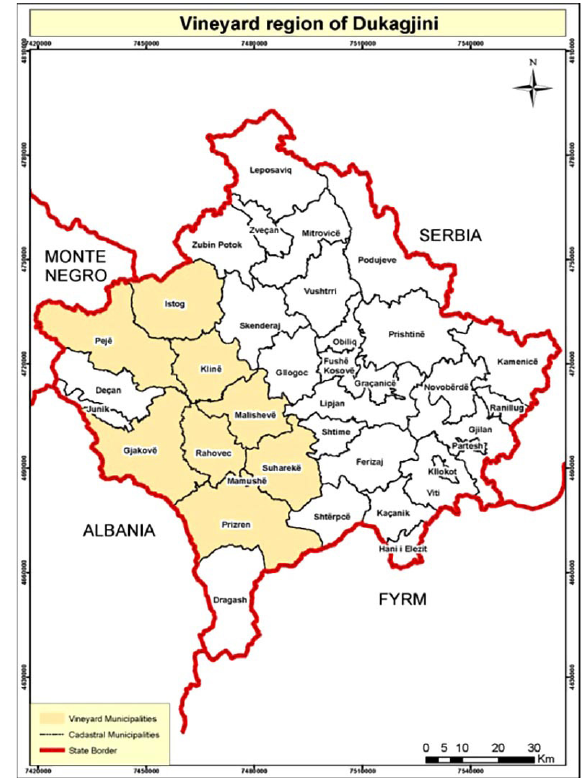
Figure 1. Viticulture